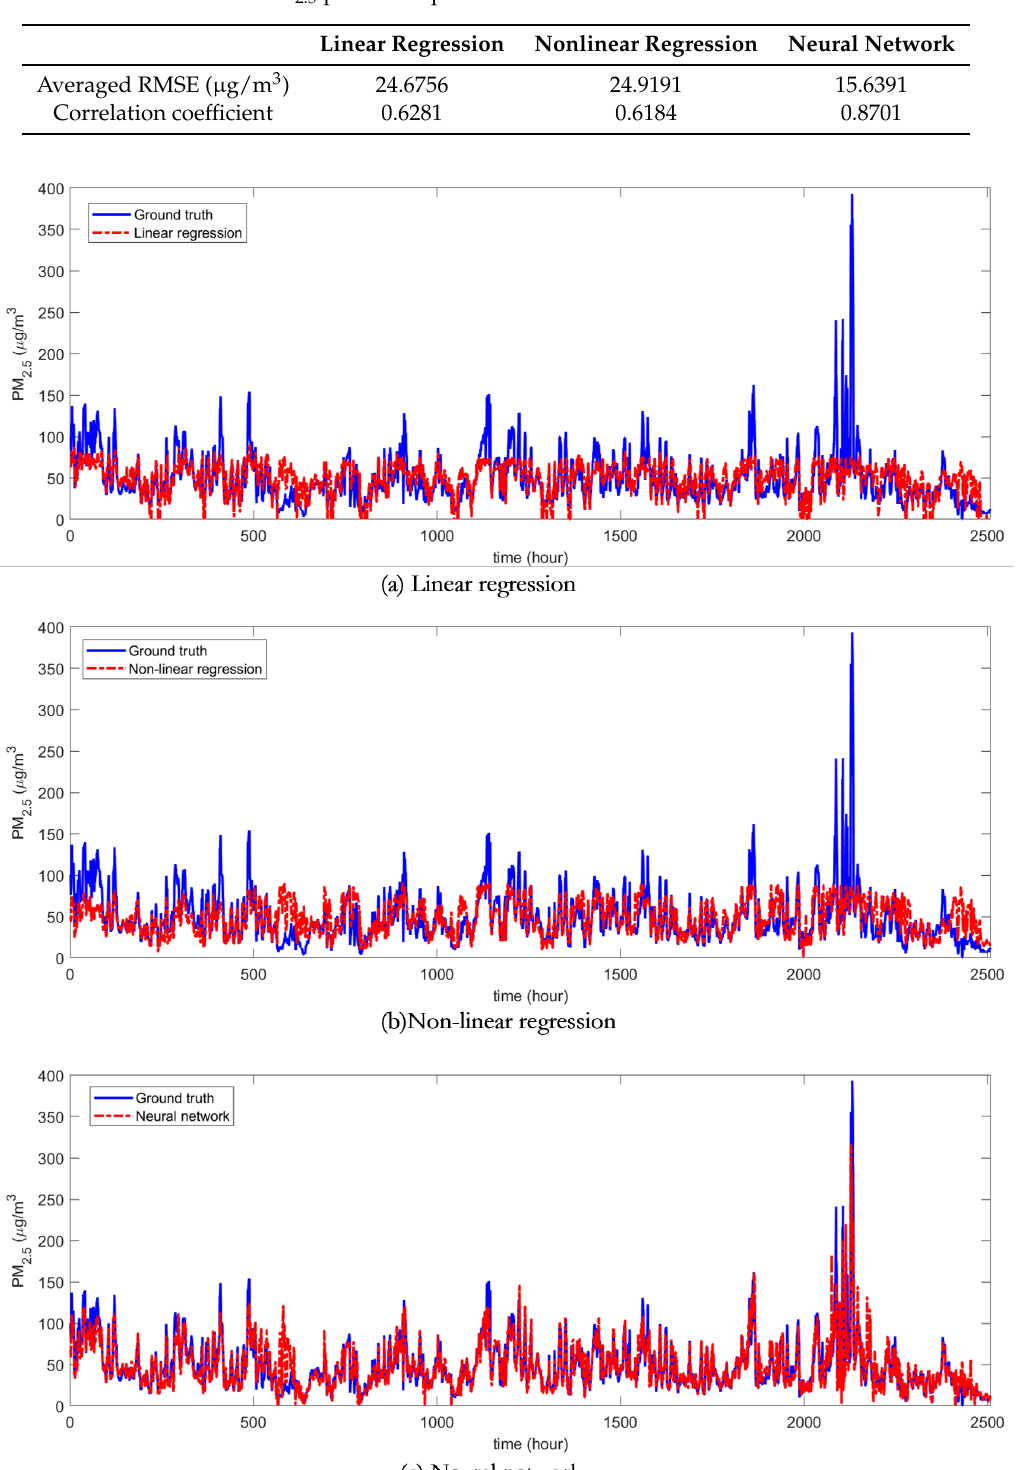
Table 2. PM 2.5 prediction performances of three different